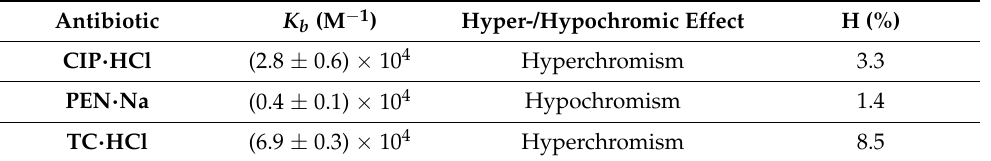
Table 1. The DNA binding constants ( K b ) for CIP · HCl , PEN · Na , and TC · HCl